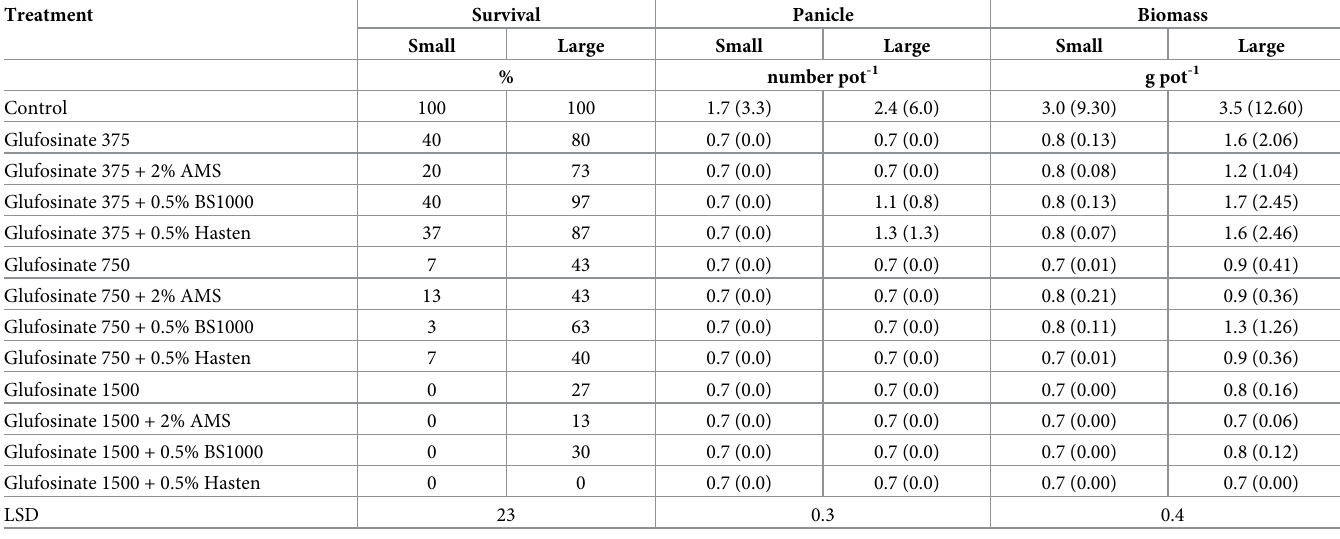
Table 3. Effect of different doses of glufosinate (with and without adjuvants) on survival, panicle production, and shoot biomass of glyphosate-resistant Chloris vir- gata . Herbicides were sprayed on small (8–10 leaf stage) and large (24–28 leaf stage) plants.